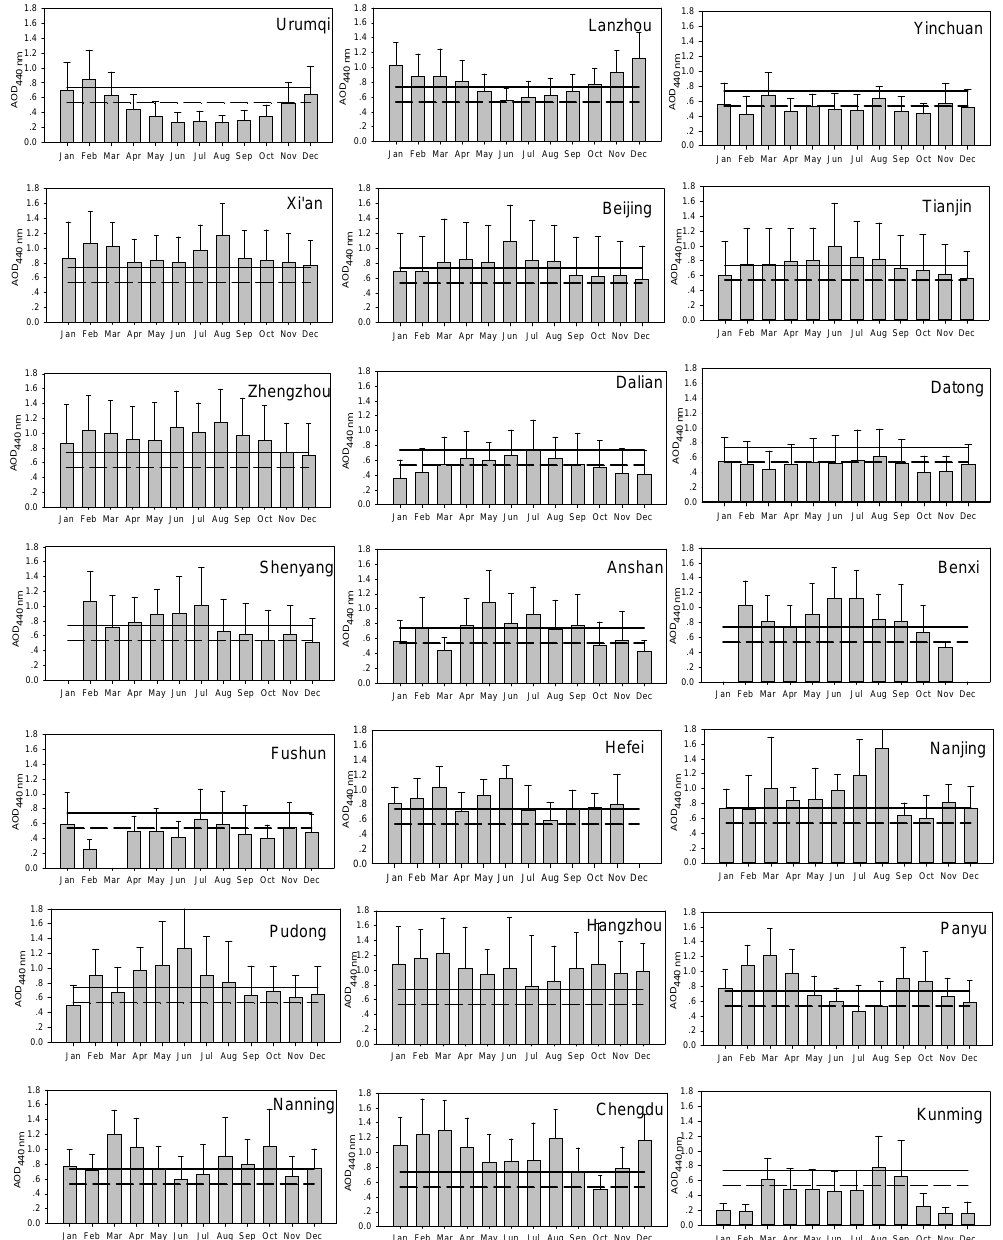
Figure 14. Monthly averaged AODs at 440nm at urban sites. The solid and dash horizontal hairlines indicate the annual averages for the subgroup and the whole database,